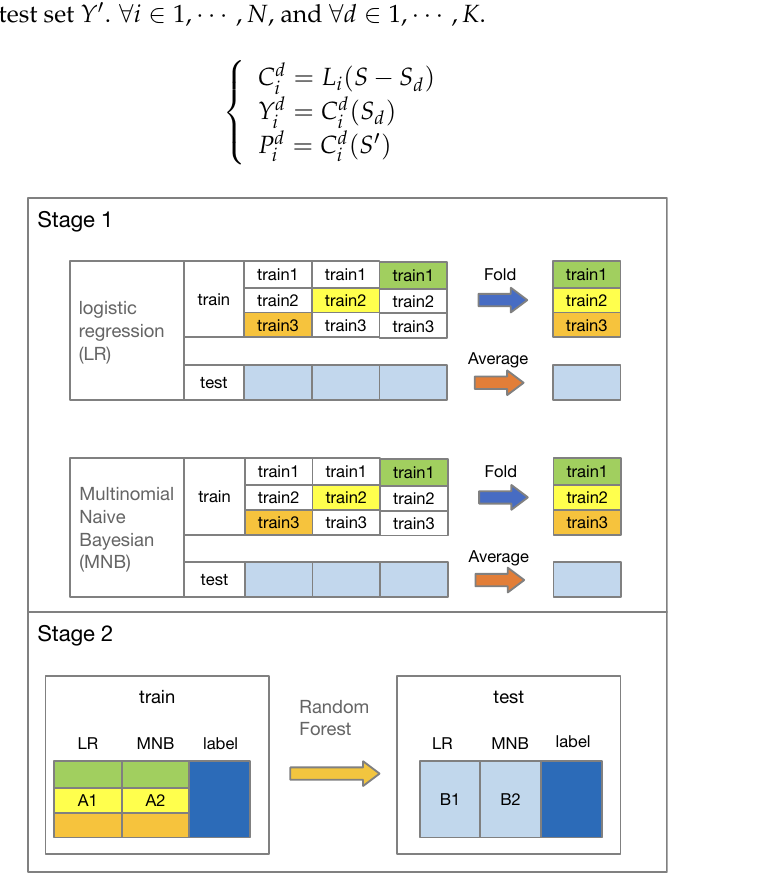
Figure 5. Stacking classifier